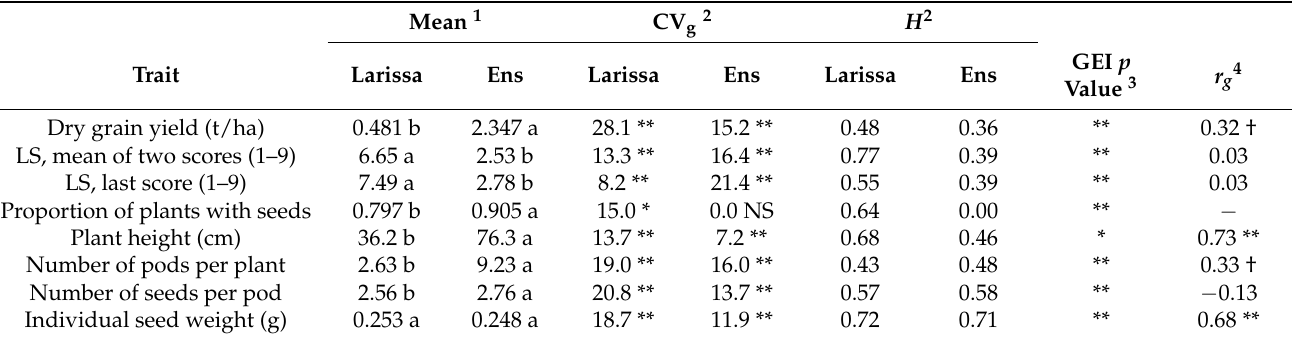
Table 2. Mean value, genetic coefficient of variation (CV g ), broad-sense heritability on a line mean basis ( H 2 ), F value for genotype × environment interaction (GEI), and GEI extent according to the genetic correlation for line responses across environments ( r g ), for grain yield, a visual lime susceptibility (LS) score, and five other traits recorded on 140 white lupin inbred lines grown in Larissa (Greece) and Ens (the